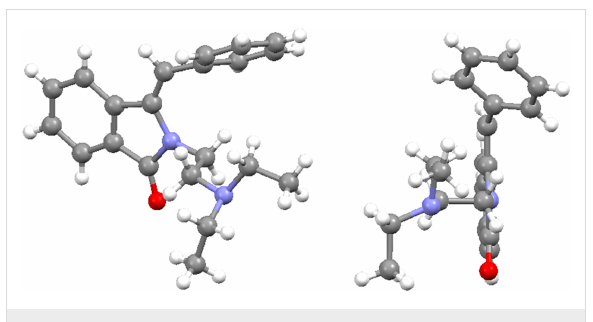
Figure 4: Crystal structure of ( Z )- 8a . Side view and front